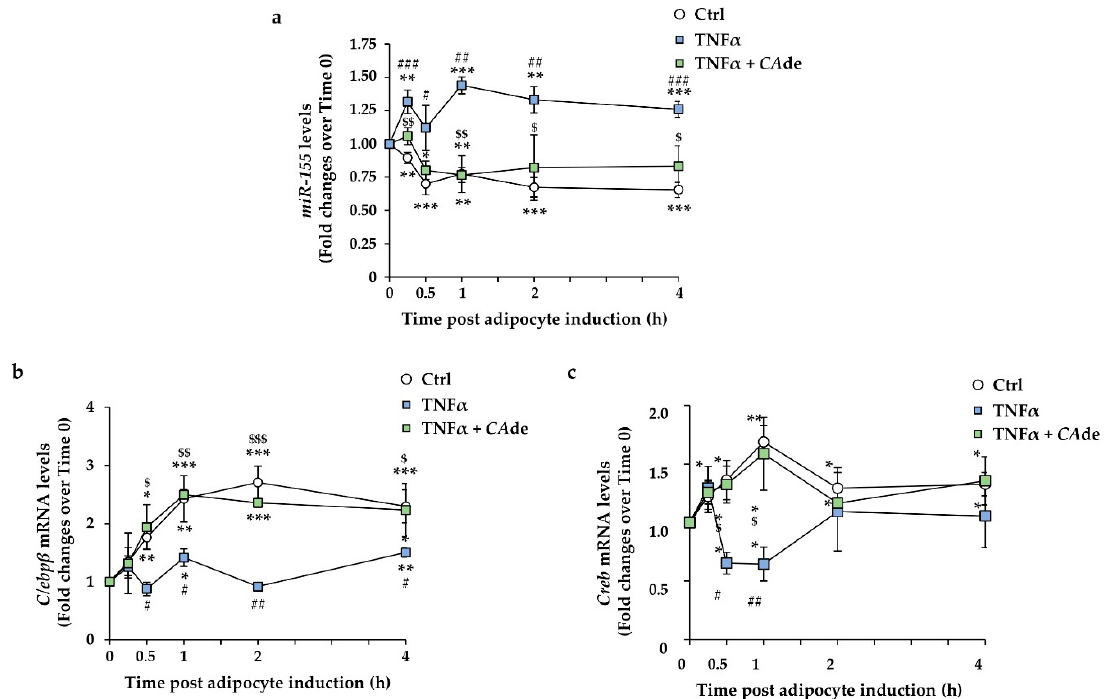
Figure 5. E ff ect of CA de on the expression of miR-155 and its target genes, C / Ebp β and Creb , during the early stage of adipogenesis in 3T3-L1 cells exposed to TNF α . 3T3-L1 pre-adipocytes were cultured for 0.25, 0.5, 1, 2, and 4 h with AS (Ctrl) or AS supplemented with TNF α (1 ng / mL) ± CA de (100 µ g / mL). The miRNA and gene expressions were evaluated by quantitative real-time PCR. Time course of miR-155 ( a ), C / Ebp β ( b ), and Creb ( c ) levels in Ctrl, TNF α -, and TNF α + CA de-treated cells are shown relative to untreated 3T3-L1 cells at time 0. Values are means ± SEM of three independent experiments. Control value at time 0 was set as 1.00. Statistical significances among groups were tested by one-way ANOVA followed by Bonferroni correction post-hoc test (* p < 0.05, ** p < 0.01, and *** p < 0.001 vs. untreated 3T3-L1 cells at time 0; # p < 0.05, ## p < 0.01 and ### p < 0.001 vs. control 3T3-L1 cells; $ p < 0.05, $$ p < 0.01, $$$ p < 0.001 vs. TNF α -treated 3T3-L1 cells).